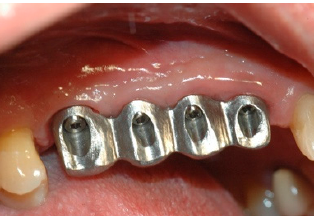
Figure 8. Mesostructure test.